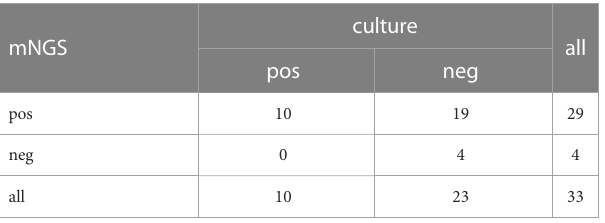
TABLE 2 Comparison of mNGS and culture results in the UTI-suspected group (n=33).